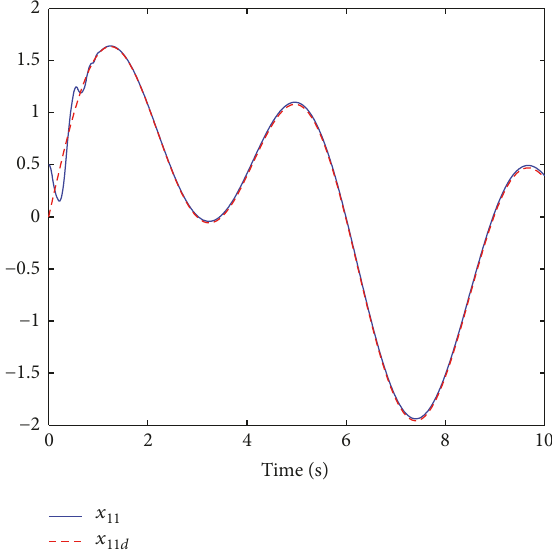
Figure 1: Tracking result of 𝑥 11 in response to 𝑥 11𝑑 .